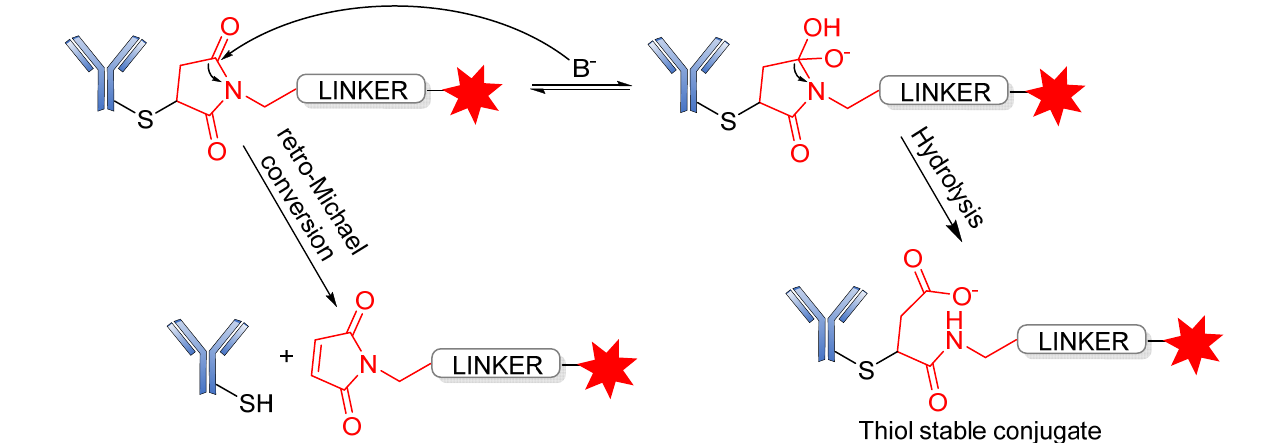
Figure 19. Side-reactions undergone by the succinimide–thioether moiety.